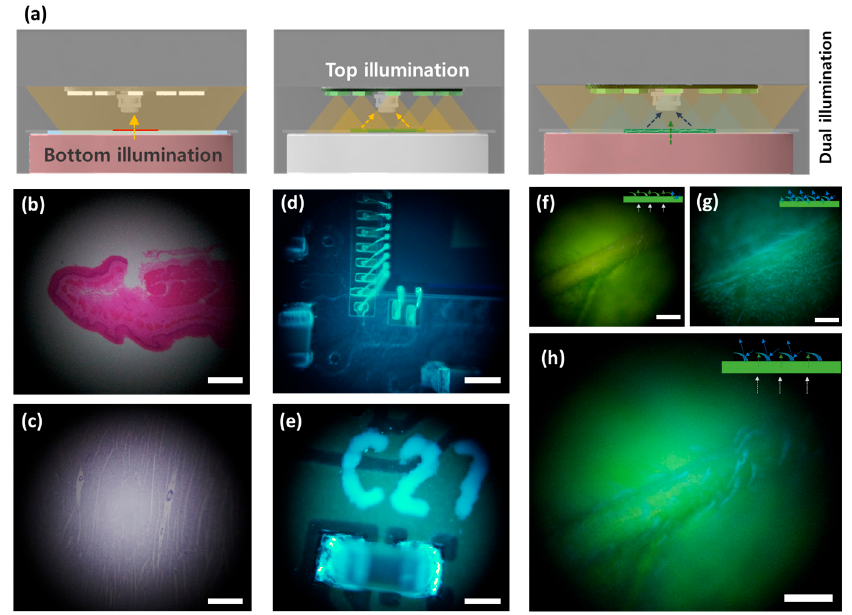
Figure 4. Multi-mode illumination imaging of MCM. ( a ) Schematic illustrations of multi-mode illumina- tion imaging. The transmission light microscopy mode uses the bottom illumination, and